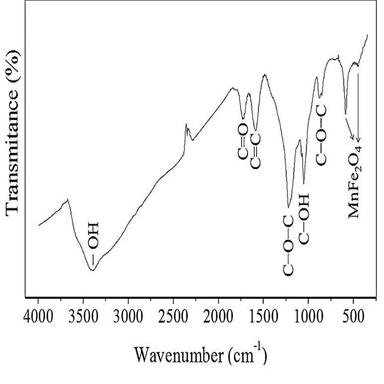
Infrared spectrum of GO-MnFe2O4/VAC.